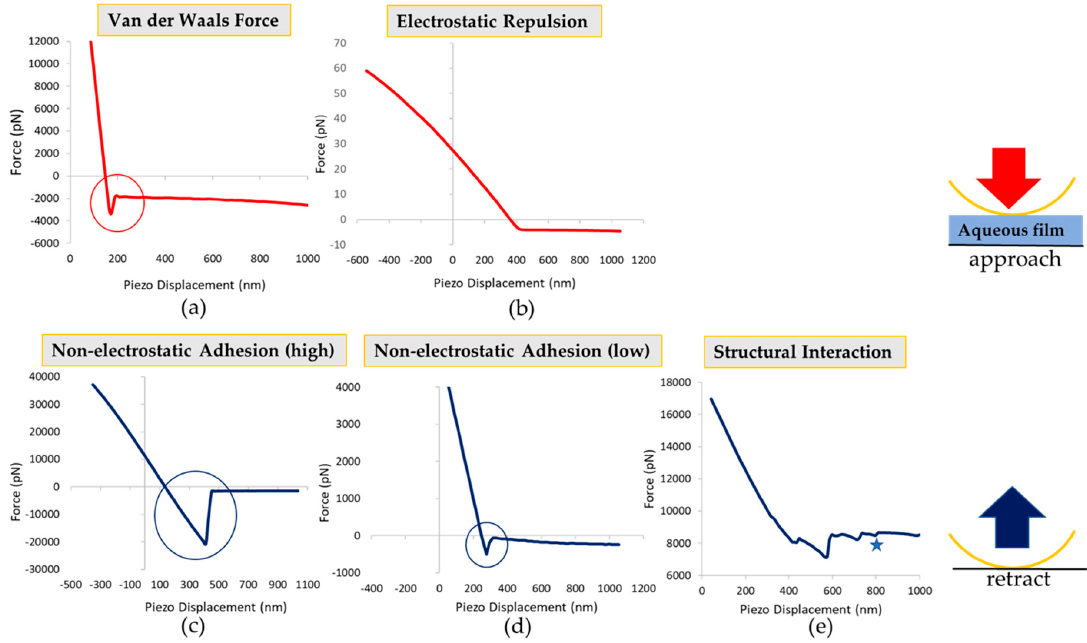
Figure 15. Force-displacement curves as the AFM tip approaches ( a , b ) and is retracted ( c – e ) from a surface. Van der Waals (VDW) forces and electrostatic repulsion (Figure 15a,b) may be sensed in the approach portion of the AFM force curve while non-electrostatic adhesion and structural force can be detected in the retraction portion (Figure 15c–e).